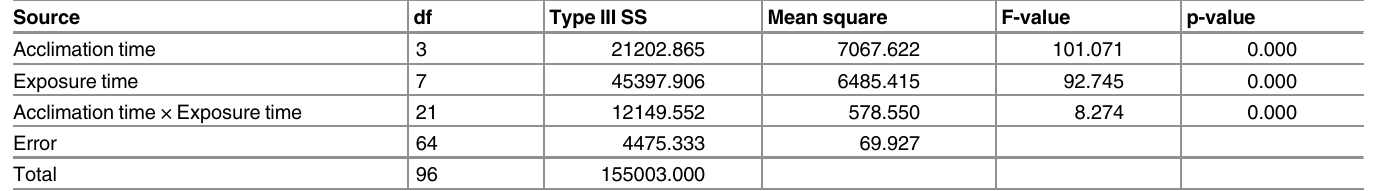
Table 4. Two way analysis of variance (ANOVA) parameters for main effects and associated interactions for the mortality of S . zeamais exposed to 47°C.